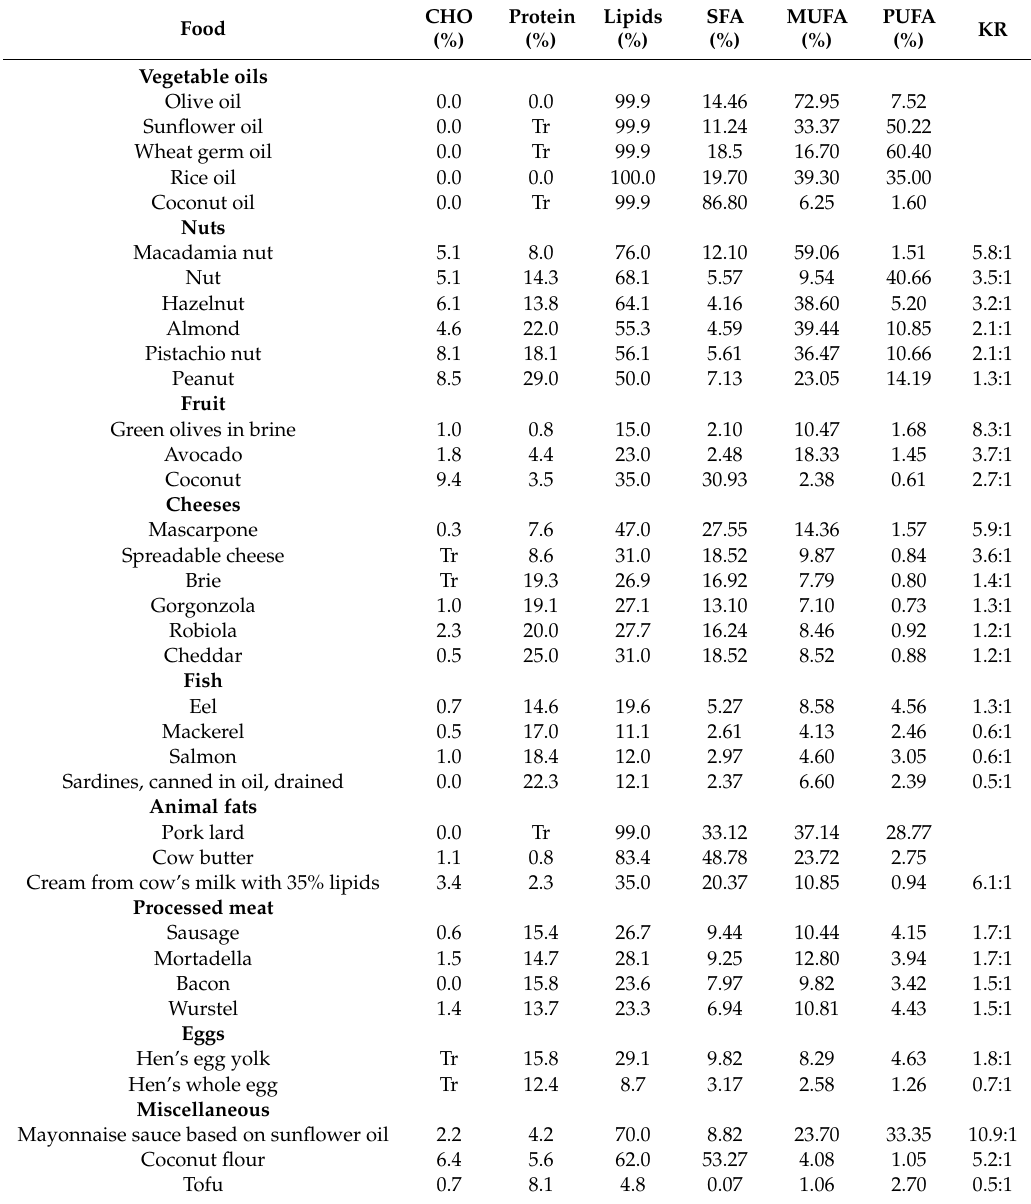
Table 1. Macronutrients content and ketogenic ratio of the most common foods used in a ketogenic dietary